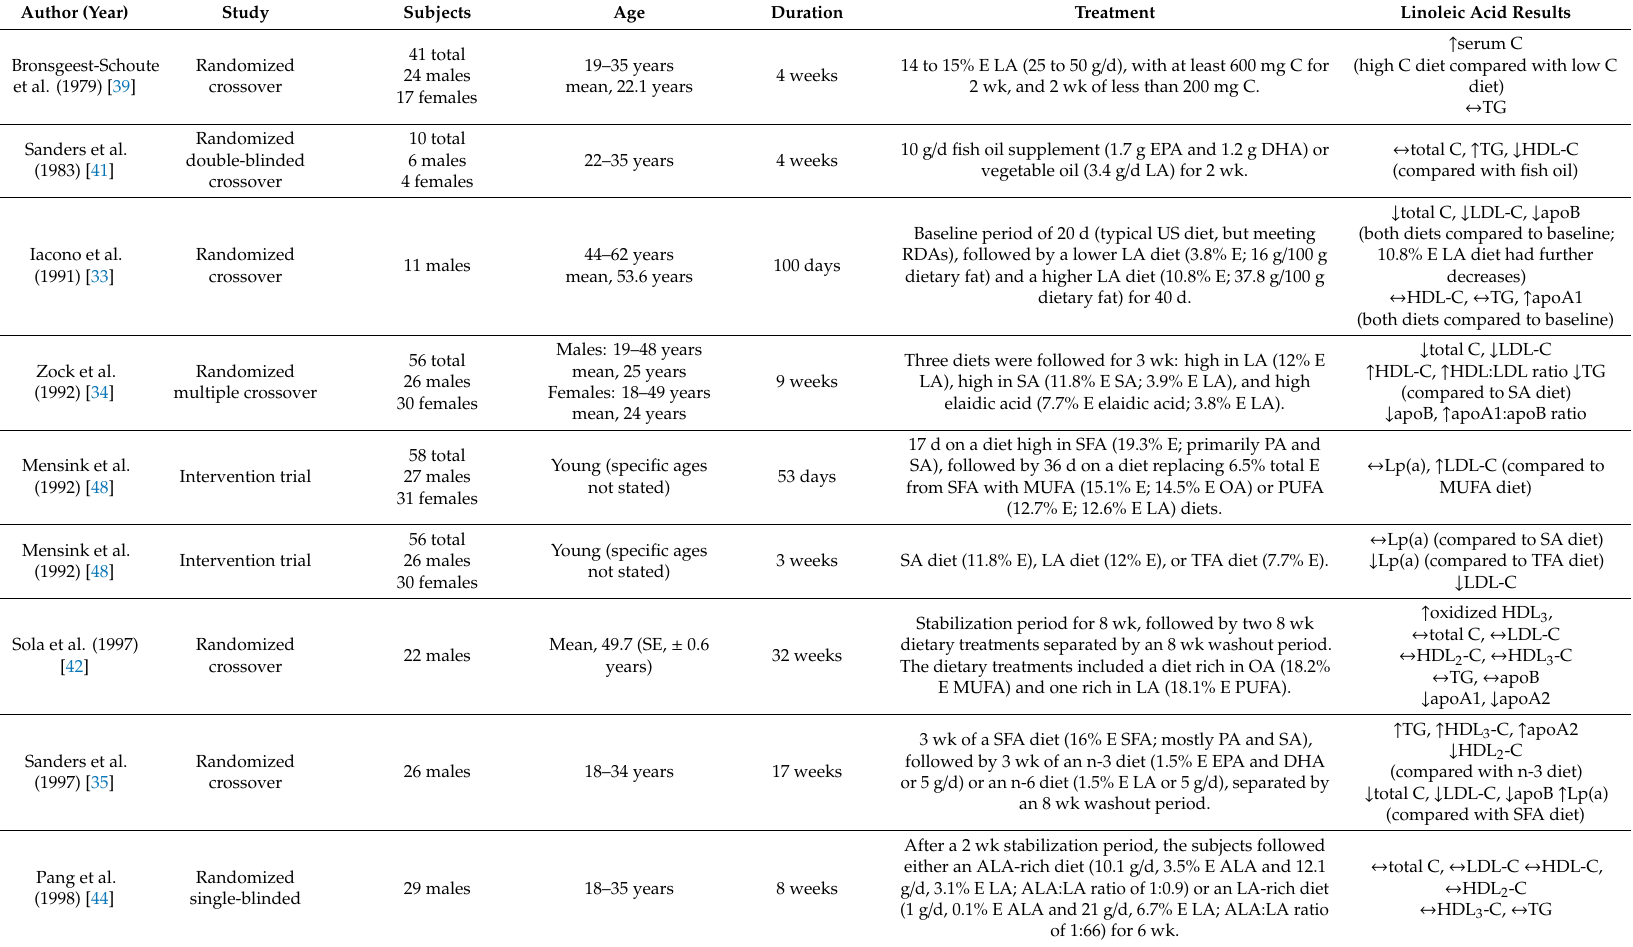
Table 3. A summary of the e ff ects of linoleic acid consumption on lipid risk markers for cardiovascular disease in healthy individuals (ordered by date of